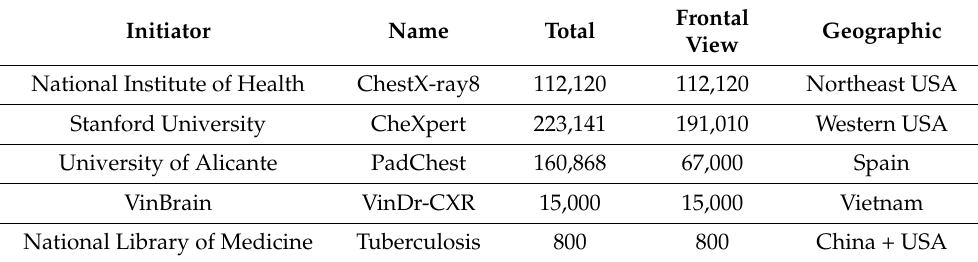
Table 2. Popular Chest X-ray datasets.